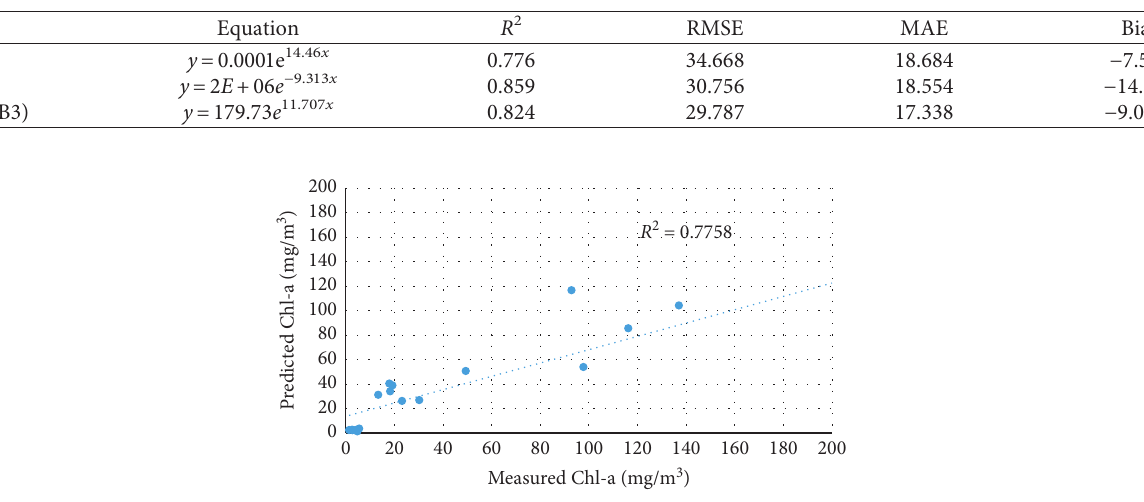
Figure 10: Regression between the Sentinel 2 band index and measured Chl-a, using the Ln(B2/B3) model. Table 6: Validation results of Sentinel 2 Chl-a models.